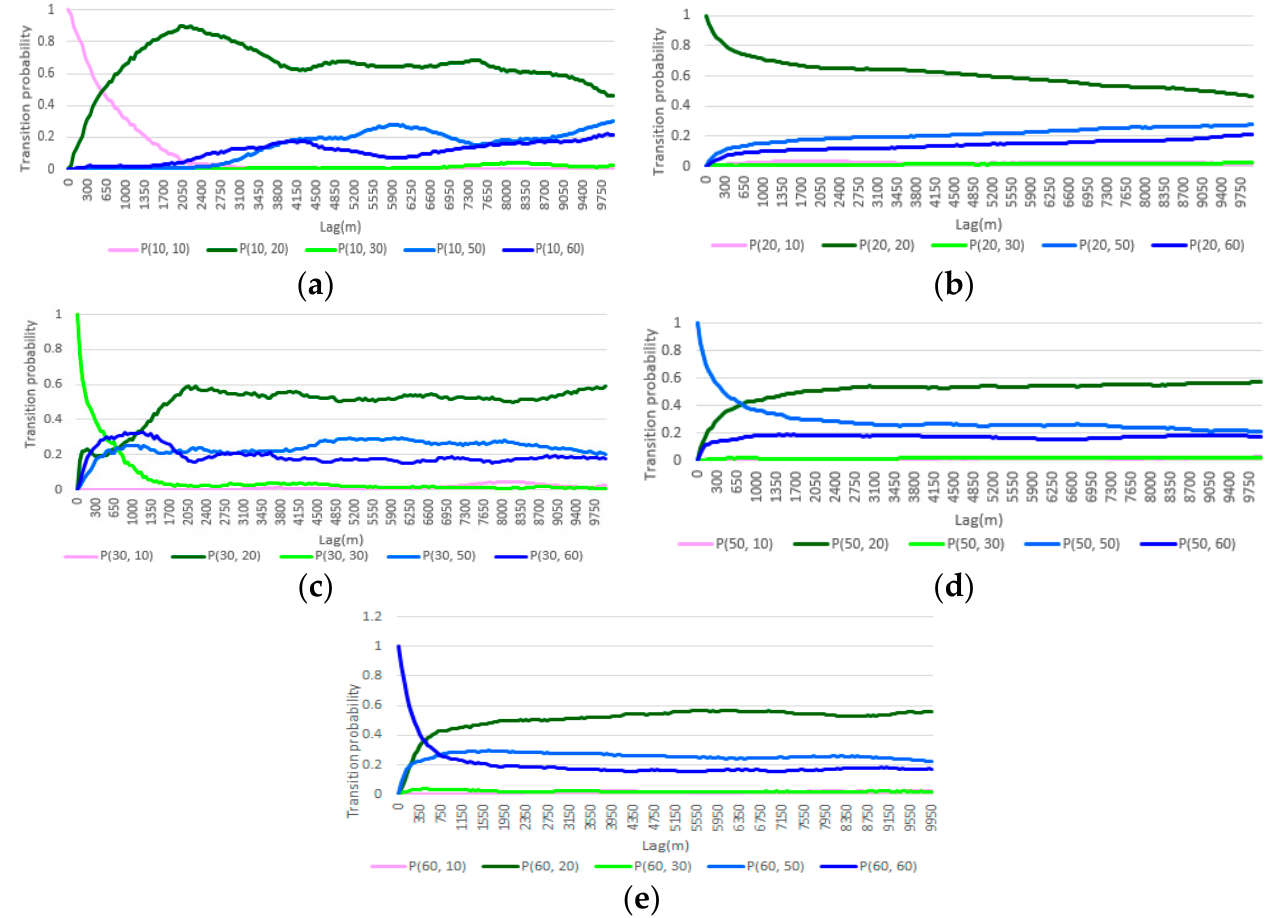
Figure 3. Demonstration area of ( a ) Globeland30-2015 and ( b ) interpreted sample points distribution map.